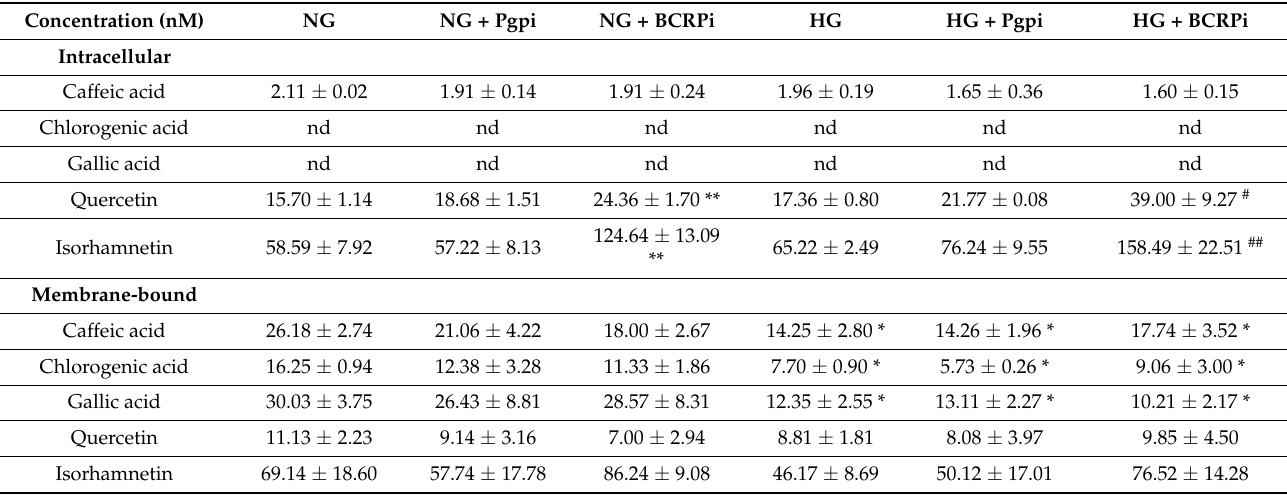
Table 1. Concentrations of polyphenols detected at the intracellular level or membrane-bound to cerebral endothelial cells. Concentration